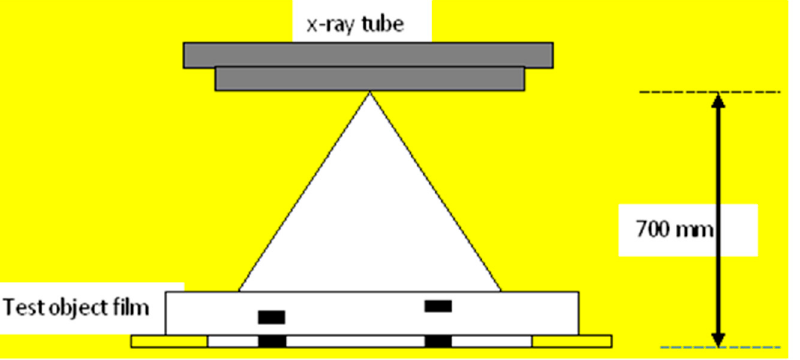
Figure 4. A basic setup of radiography.